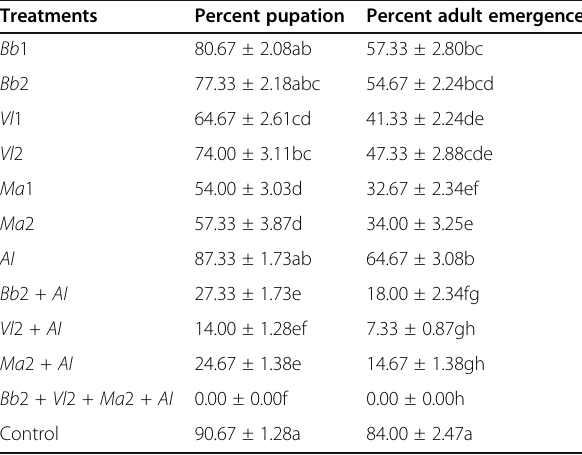
Table 3 Percent pupation and percent adult emergence (mean ± SE, n = 5) of 2 nd instar Pectinophora gossypiella larvae due to Beauveria bassiana , Verticillium lecanii , Metarhizium anisopliae concentrations and Azadirachta indica extract (alone and in combination). Means sharing with same lower case letters are not significantly different from each other at 0.05 level of significance, i.e., P <